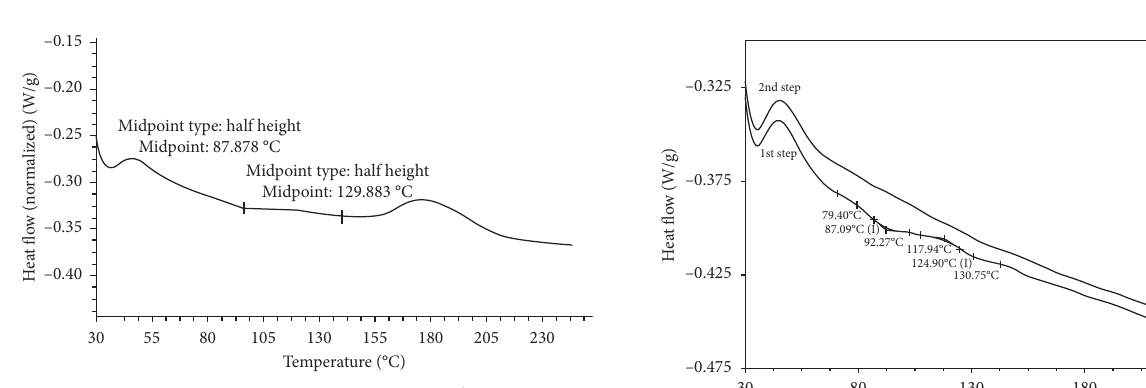
Figure 8: Sample without thermal load: 1 st heating.